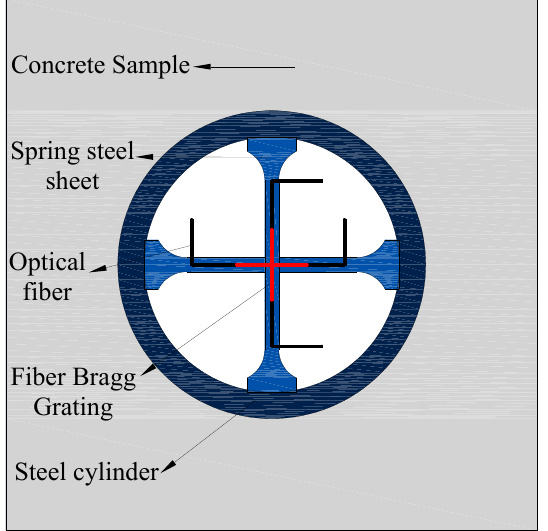
Figure 1. Structure of a cylindrical bidirectional strain sensor based on FBG.